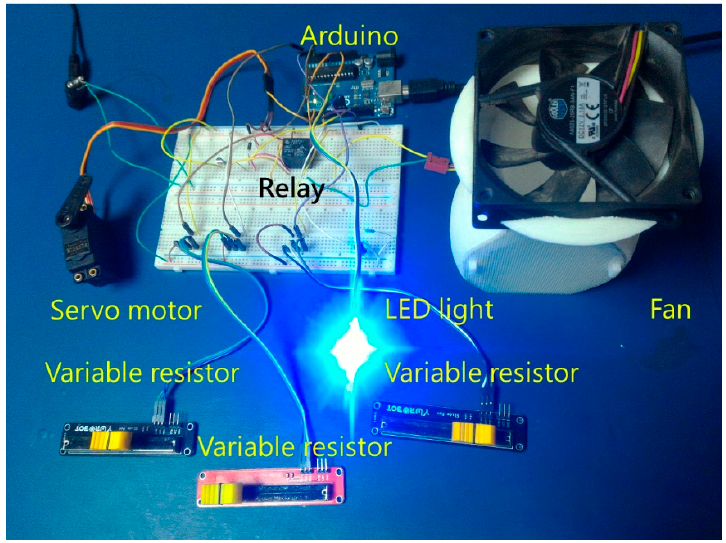
Figure 20. View of experimental devices.